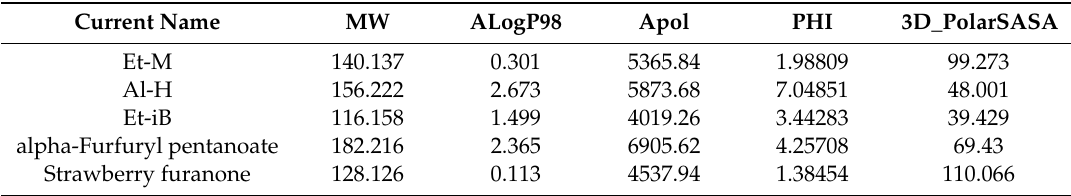
Table 2. Molecular descriptor values of the three molecules used in the experimental blending, the unique molecule CAR-PNA, and strawberry furanone (“caramelized